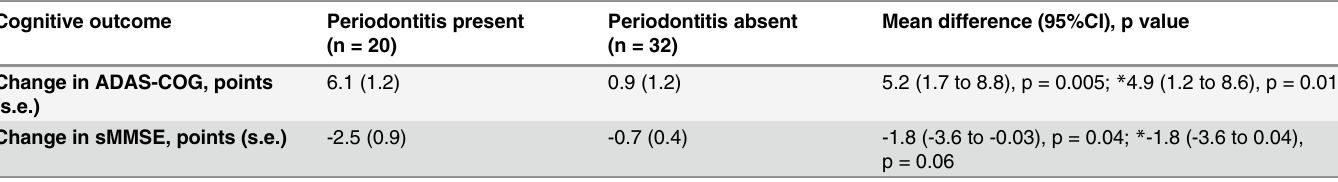
Table 2. The relationship between the presence of periodonitis at baseline and cognitive change over the six month follow up period. Cognitive outcome Periodontitis present Periodontitis absent Mean difference (95%CI), p value (n = 20) (n = 32) Change in ADAS-COG, points (s.e.) Change in sMMSE, points